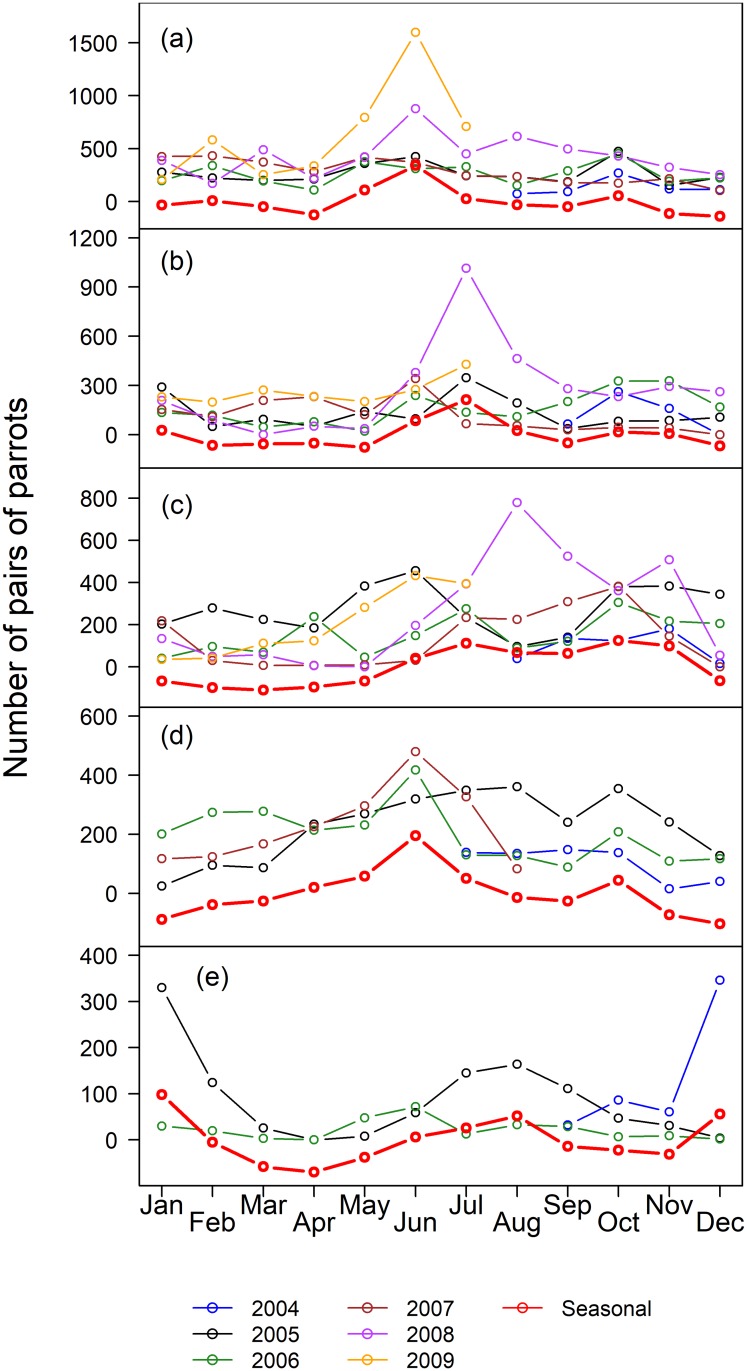
Number of pairs of parrots in five roosts in the southern Pantanal of Brazil.Years are coded by colors (see the legend below the plots), and the red line indicate the seasonal component of the counts obtained by STL-decomposition analysis (see Methods). (a) Roost 1, (b) Roost 2, (c) Roost 3, (d) Roost 4, and (e) Roost 5.